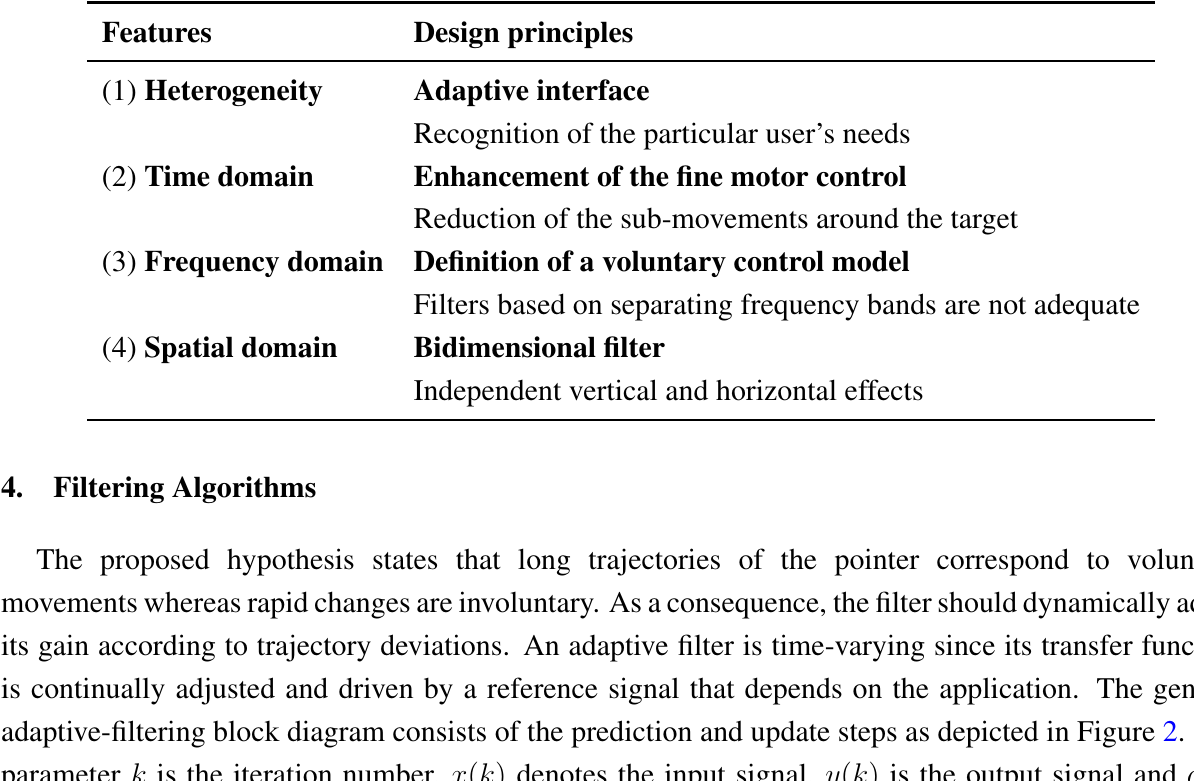
Figure 2. Adaptive-filtering block diagram.